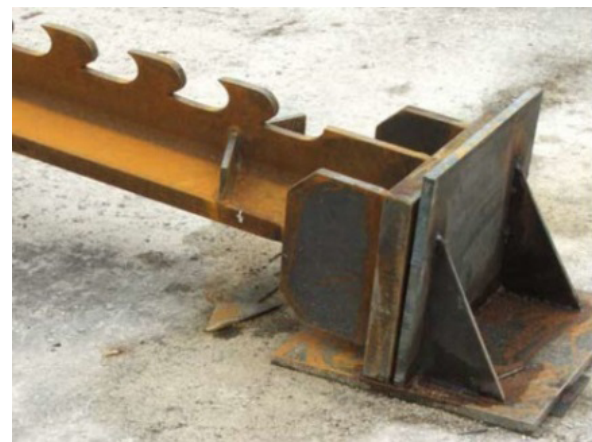
Figure 8: Steel dowels (SA shape according to [7]) used in the girders for the pedestrian bridge in Przemyśl, Poland (picture from the proposal of the PreCo-Beam project